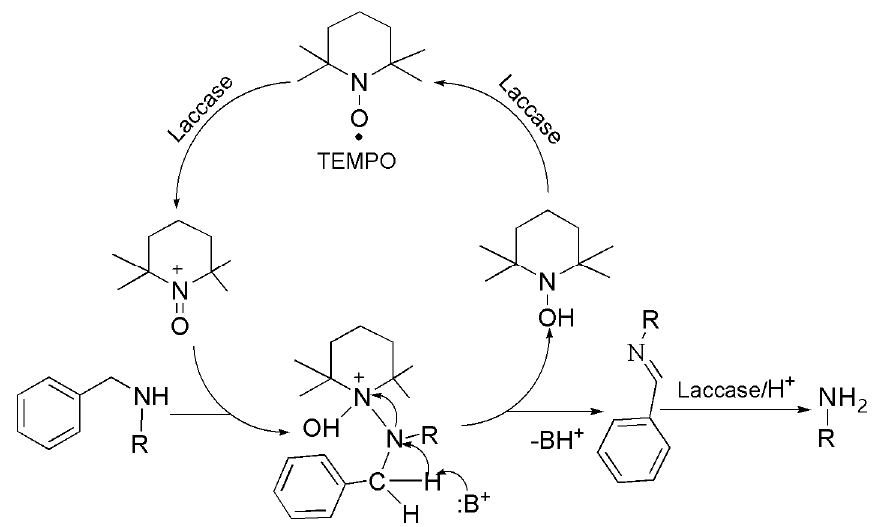
Figure 5. Possible mechanism of C–N bond breakage catalyzed by laccase.